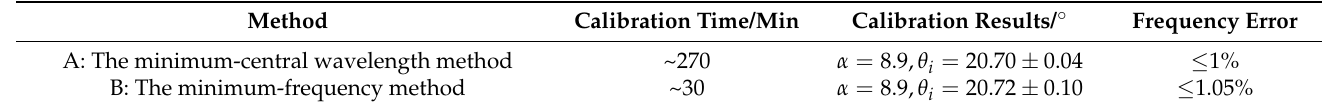
Table 2. The advantages and disadvantages of the two calibration methods.